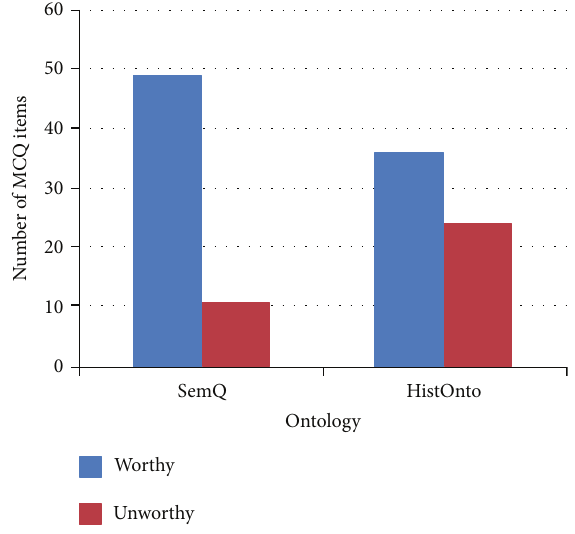
Figure 1: Worthy versus unworthy